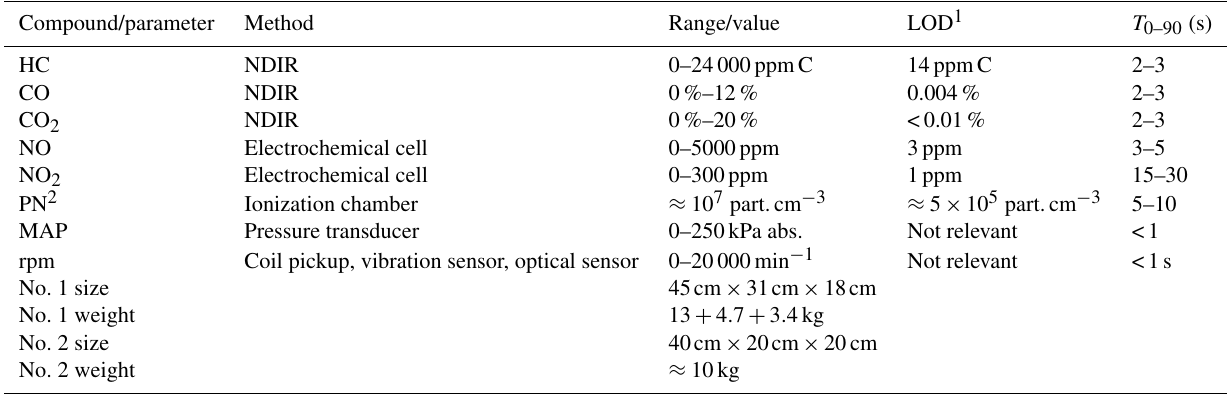
Table 3. Mini-PEMS technical